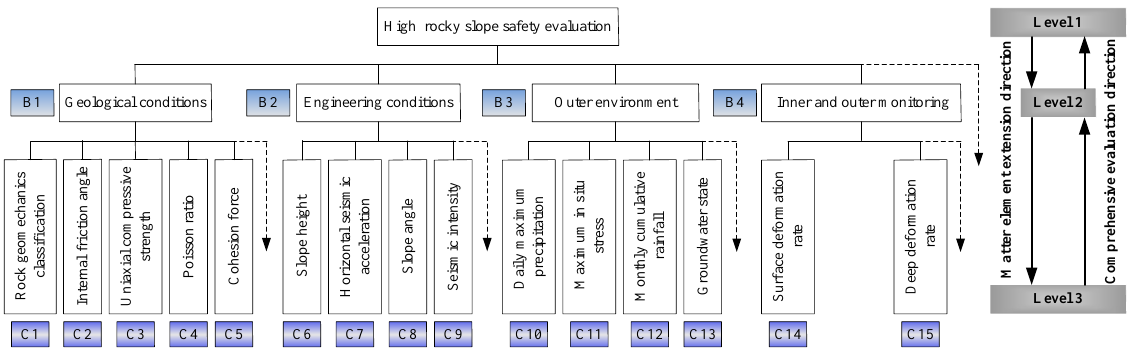
Figure 1. Safety evaluation hierarchy of high rocky